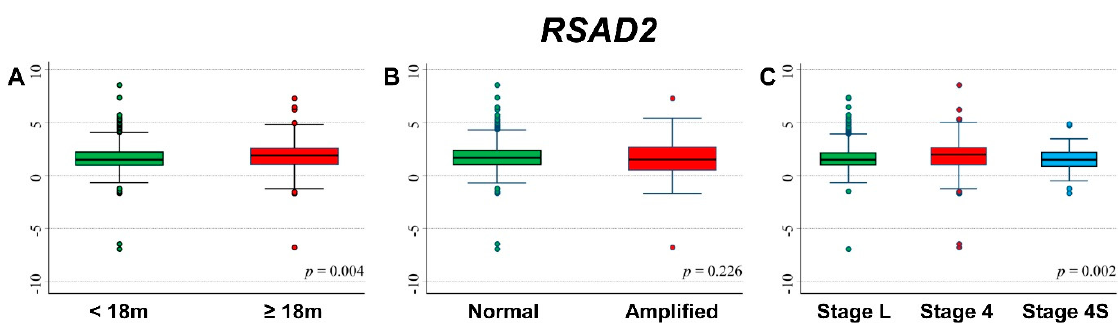
Figure 12. Association between RSAD2 gene expression and the main patient characteristics at diagnosis. ( A ) Age; ( B ) MYCN status; ( C ) Stage.